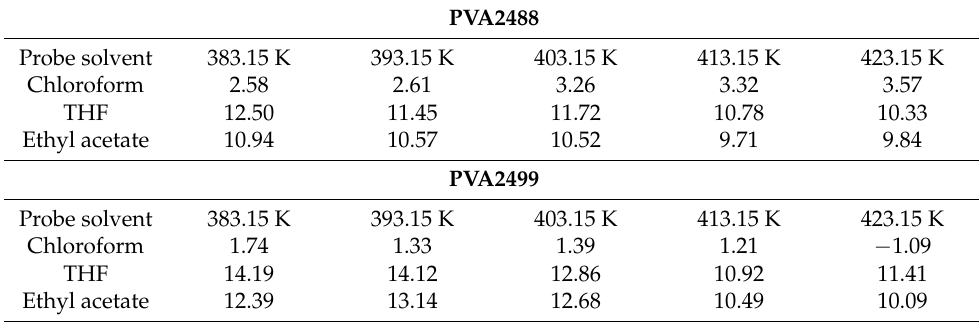
Table 9. Surface characteristics of PVA2488 and PVA2499 at different temperatures adsorption free energy ∆ G sp